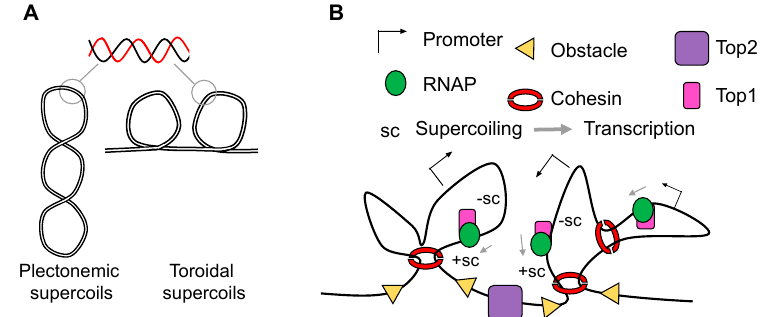
Figure 3. Supercoiling contributes to loop formation. ( A ) Supercoiled DNA folds into plectonemic (left) or toroidal (right) conformations. While plectonemic structures have been observed in bacterial chromosomes, toroidal supercoils are found constrained within nucleosomes. Here, both cartoons depict negative supercoils. For a detailed description of DNA topology, please see [53]; ( B ) Topoisomerase activity is regulated to ensure that negative supercoiling is maintained along transcribed units. Positive supercoils accumulate in front of the polymerase.